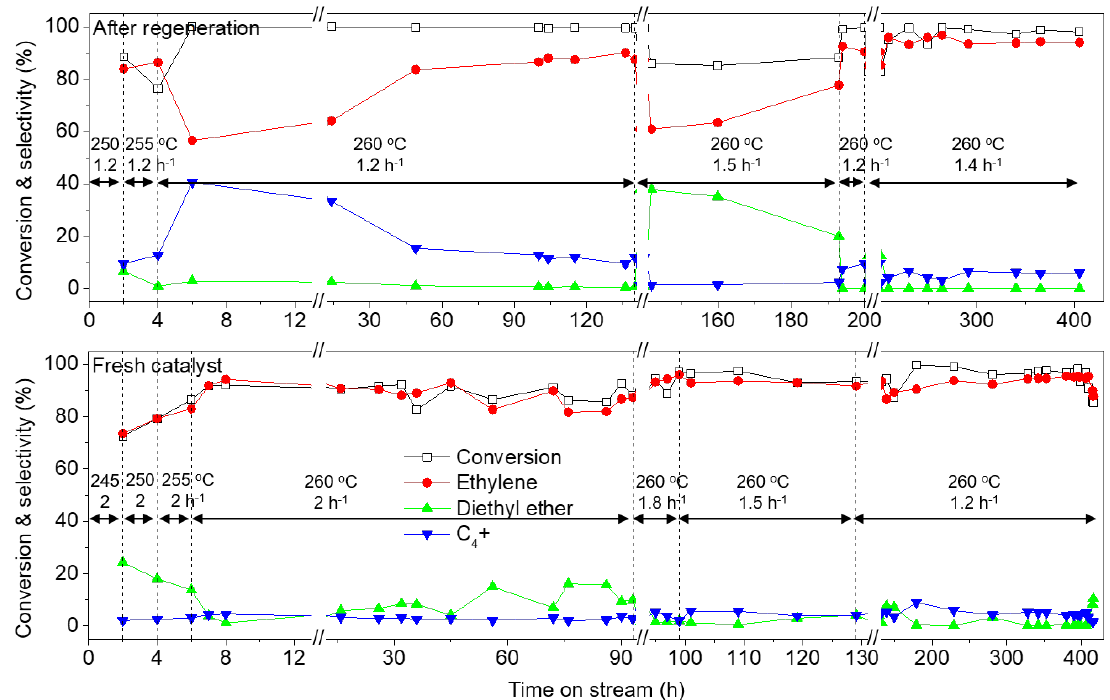
Figure 7. Et hanol conversion (□) and selectivities to ethylene (● ), diethyl ether ( ▲ ), and C 4 + compounds ( ▼ ) as a function of TOS in dehydration of bioethanol over 12 g of 0.3 wt. % of lanthanum loaded La/H-ZSM-5A4 catalyst at 245 – 260 °C and 1.2 – 2 h − 1 WHSV (bottom), and successive reaction under identical conditions as given above after regeneration of catalyst in air flow (100 mL min − 1 ) at 550 ◦ C (ramping rate of 10 ◦ C min − 1 ) for 6 h right after previous sequence